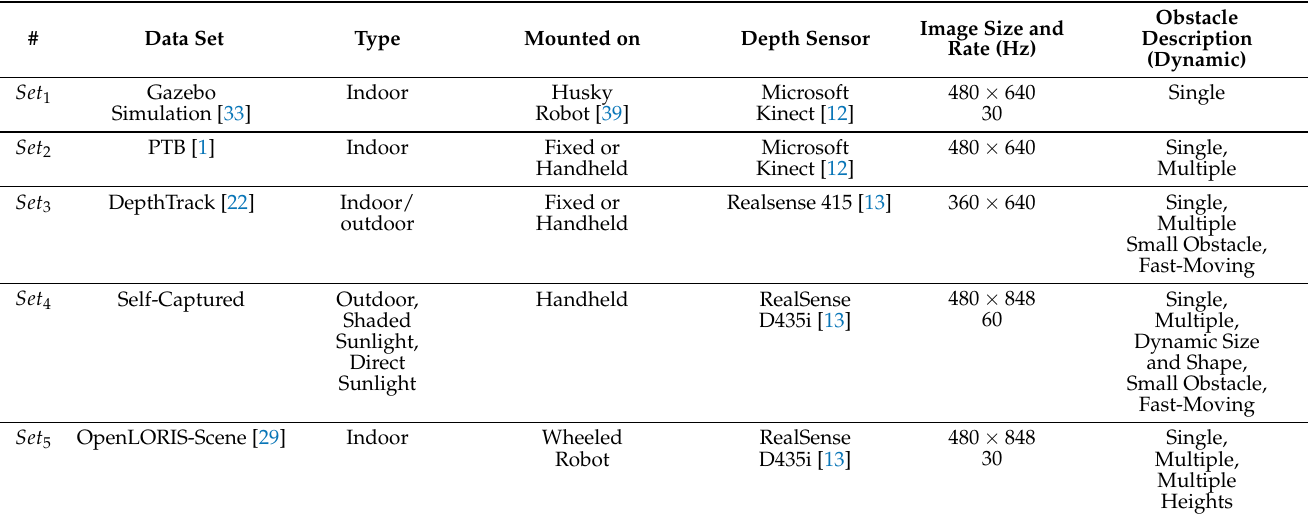
Table 1. Configurations of all experimental data